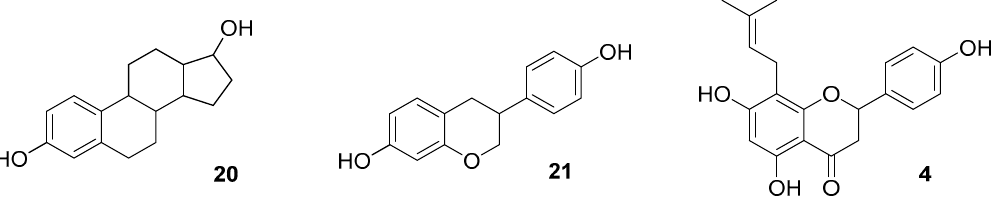
Figure 5. Comparison of chemical structures of estradiol ( 20 ), isoflavone (equol, ( 21 )) and 8-PN ( 4 )